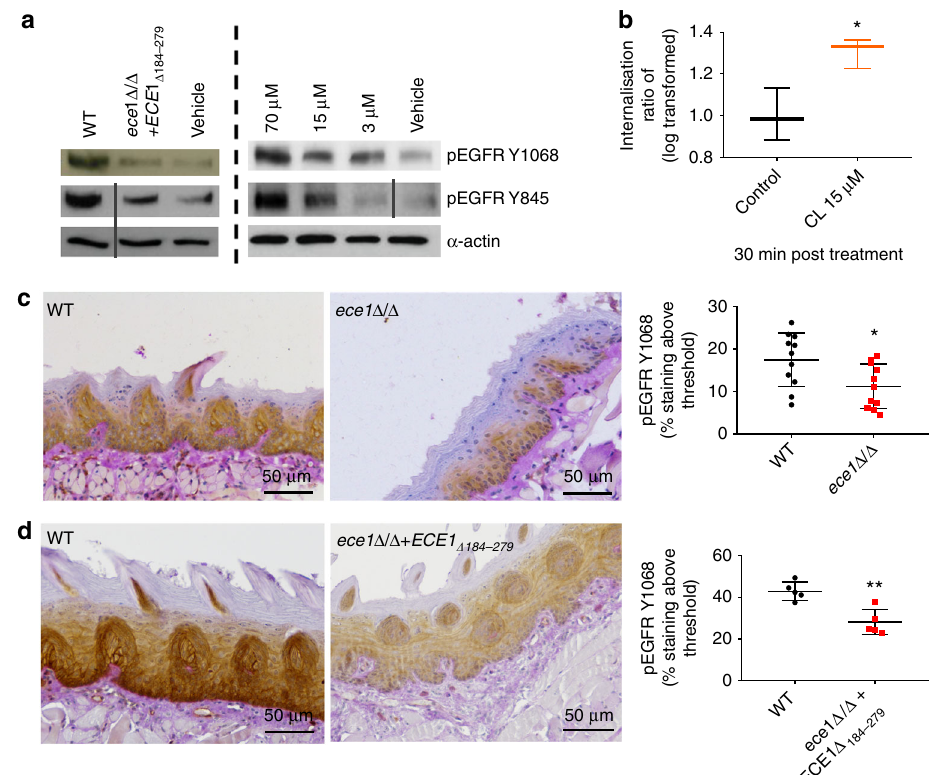
Fig. 1 Candidalysin (CL) activates EGFR. a Phosphorylation: Infection of TR146 cells with WT C. albicans induces EGFR phosphorylation at two distinct tyrosine sites, Y1068 and Y845, while a strain lacking the candidalysin-encoding region ( ece1 Δ / Δ + ECE1 Δ 184 – 279 ) does not (left panel). Phosphorylation of EGFR at both sites was also induced following direct candidalysin treatment in a dose-dependent manner (right panel). Data are representative of three biological repeats. Protein lysates were taken at 2 h p.i. for western blot analysis. Solid vertical lines indicate omitted, extraneous portions of blot images. b Internalisation: At 30 min post CL treatment, EGFR is signi fi cantly internalised. Data collected from a total of 120,000 cells per group over three independent experiments. Median value indicated, error bars represent min-max data points. Values are shown as a Log transformed ratio of EGFR staining intensity inside the cell to the total cell intensity of EGFR staining. c Murine pEGFR staining: Immune compromised mice were infected with a C. albicans ece1 Δ / Δ mutant (lacking ECE1 which encodes the parent protein from which candidalysin is derived) and tongues were harvested at day 1 p.i. Paraf fi n- embedded, 3 mm tissue sections were prepared and stained for pEGFR (Y1068). The ece1 Δ / Δ mutant exhibits reduced capacity to phosphorylate EGFR above a given threshold (threshold set using Image J software), when compared to WT C. albicans infections. Data from 9 (WT) and 11 ( ece1 Δ / Δ ) individual mice obtained over two independent experiments. d Murine pEGFR staining: Immune competent mice were infected with the candidalysin- de fi cient ece1 Δ / Δ + ECE1 Δ 184 – 279 mutant which also exhibited a reduced ability to phosphorylate EGFR at Y1068, when compared to WT infection. Data obtained from one experiment, 5 mice per group. Unpaired T -tests were used to determine statistical signi fi cance in ( b , c , d ). Error bars from ( c , d ) represent Standard deviation (SD). * p < 0.05, ** p < The data indicate that EGFR activation is required for candidalysin- induced MAPK signalling and release of GM-CSF and G-CSF during C. albicans infection.